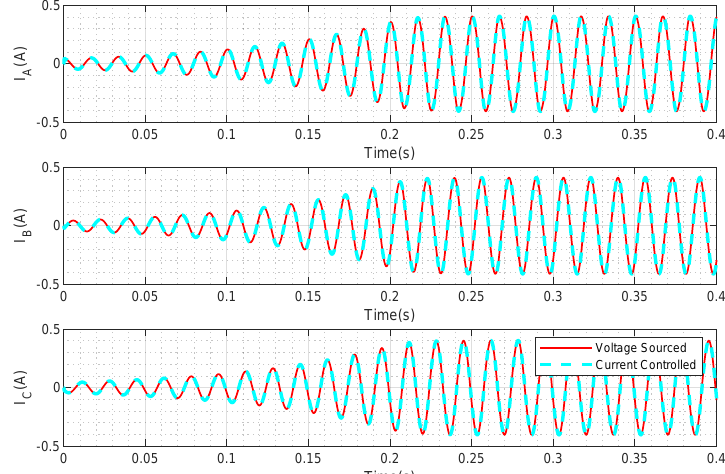
Figure 9. Simulated startup transient for both voltage-sourced and current-controlled amplifiers operated by a DZO controller. They match almost exactly, as would be expected for operations within the bandwidth of the current controller. The phase of the traces diverge slightly over longer time intervals because the two systems are not completely